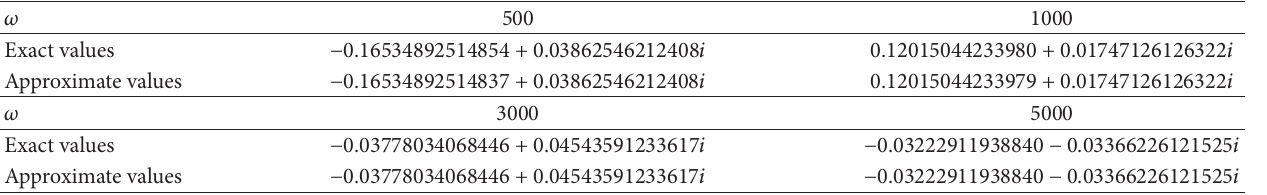
Table 6: Approximate values in 2 -point approximations by the proposed method to the integral ∫ with exact